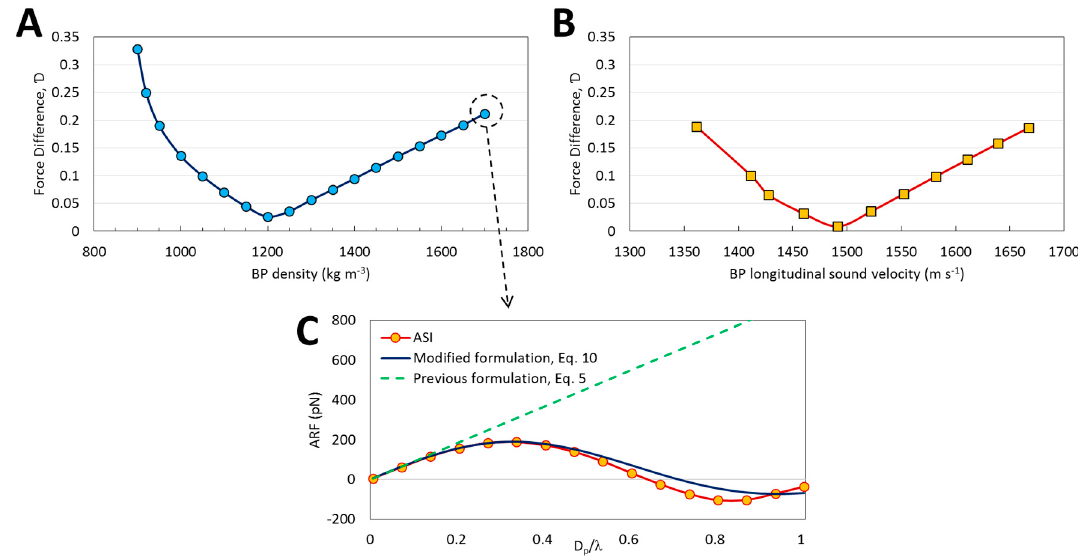
Figure 6. Investigation on the validity of Equation (10). The effect of ( A ) density and ( B ) longitudinal sound velocity of BPs on the force difference ( D ) in which the target force is the ARF calculated from Equation (10). The c p and ρ p 0 are kept constant based on values in Table 1, respectively for ( A , B ); ( C ) The ARF obtained from ASI model compared to Equation (5) and Equation (10) predictions for ρ p 0 ≃ 1700 kg m − 3 . Although the deviation of the BP density and longitudinal sound velocity from the optimal values shown in Figure 6A,B increases D , the predictions are still acceptable compared to the results obtained from previous formulations that use the small particle assumption (Equation (5)).